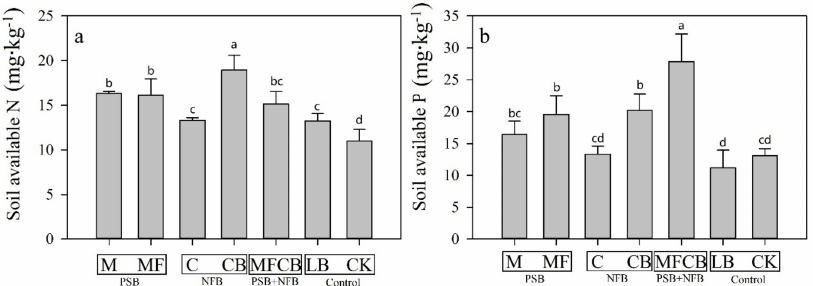
Figure 2. Contents of ( a ) soil available N, and ( b ) soil available P in the rhizosphere as a ff ected by di ff erent inoculant types (PSB, NFB, PSB + NFB). Di ff erent lowercase letters denote significances of soil